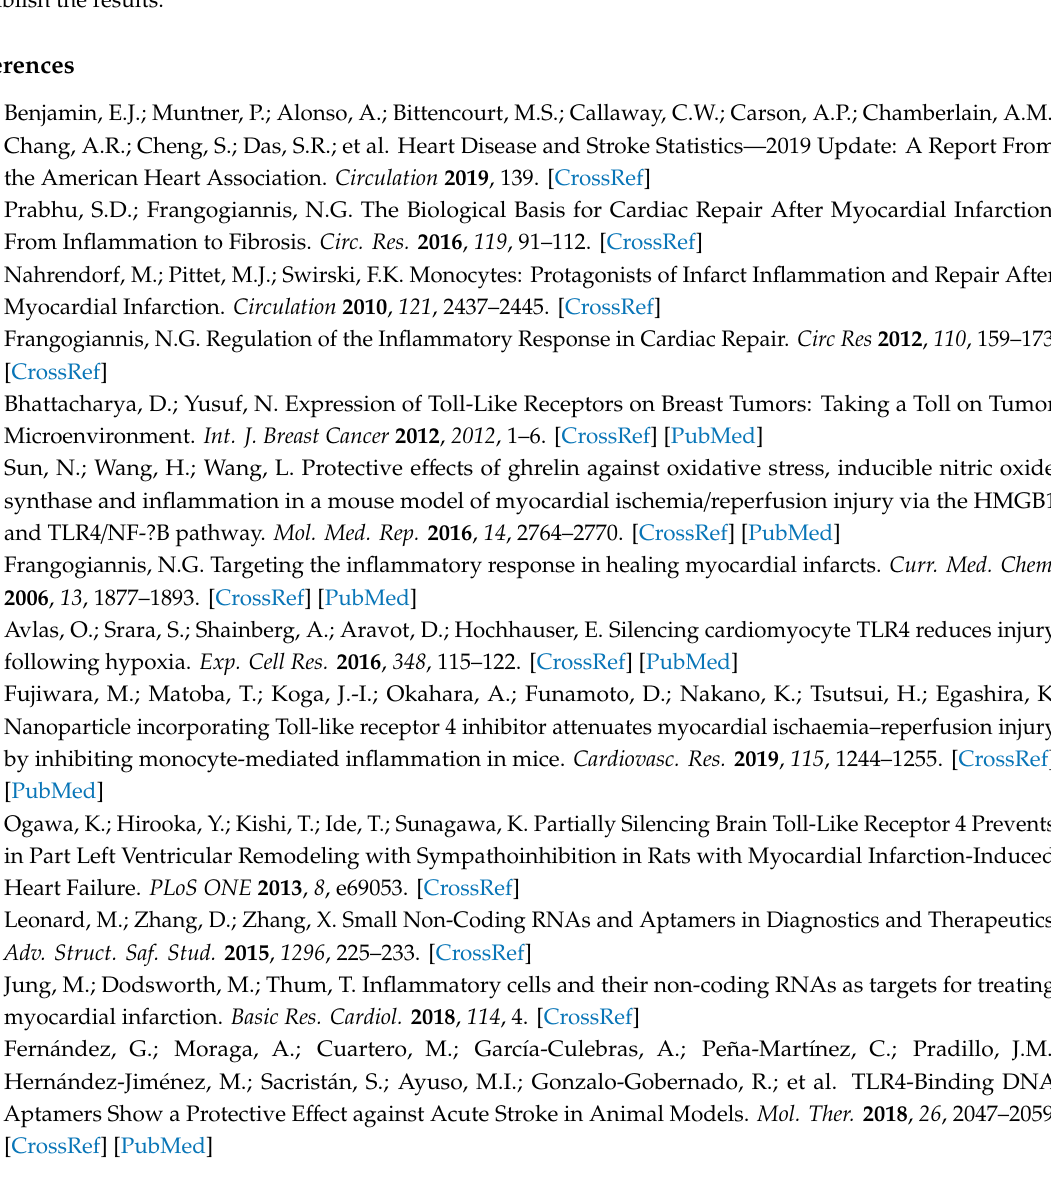
Figure S1: Basal cardiac ultrasound parameters of selected pigs included in the